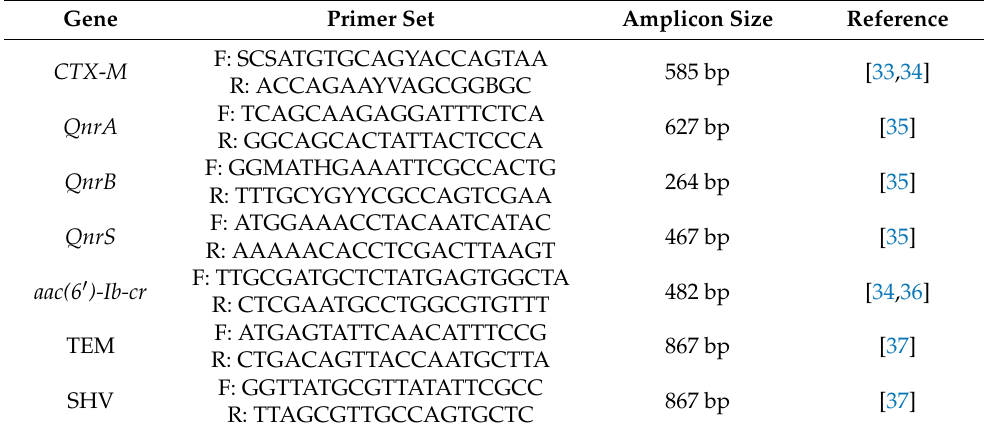
Table 6. List of primers